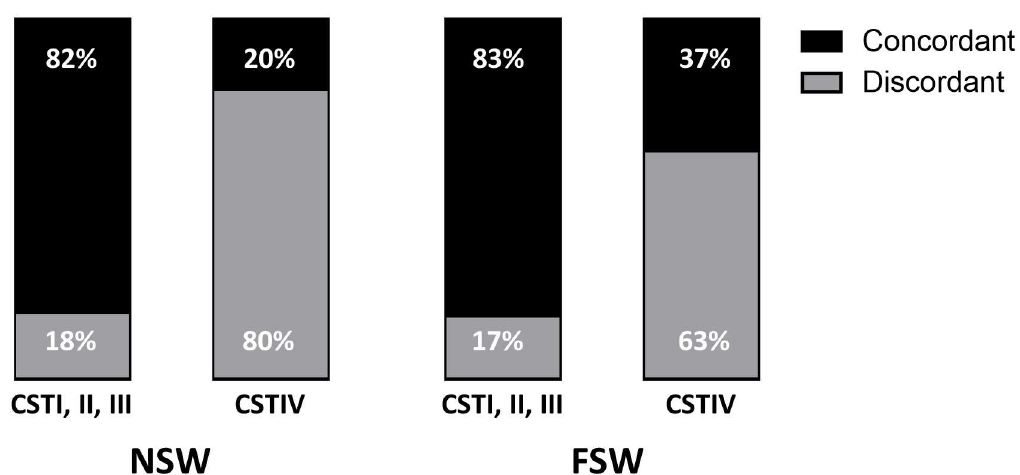
Fig 7. Concordance between bacterial morphotypes observed during Nugent Scoring and bacterial genera described by 16S sequencing. The top 5 bacterial generafor each woman were enumerated and comparedto the raw bacterialmorphotype scores ( Lactobacillus morphotypes, G . vaginalis/Bacteroides morphotypes, Mobiluncus morphotypes) obtainedduringNugent Scoring. The 16S and bacterial morphotypes were consideredto be in complete agreementif the top 5 generaobtainedby 16S sequencing includedall organismsviewedby microscopy. Overall concordance rate for NSW was 63% (10/16) completeagreement, and 44% (18/41) completeagreementfor FSW. After stratifying by Community State Type (CST) ( Lactobacillus dominant vs. high diversity), concordance rates were found to be related to CST. Concordance rates were greater for women in CSTI, II, III as comparedto CSTIV, regardless of whetherthey were NSW or FSW (9/11, 82% vs. 1/5, 20% in NSW and 5/6, 83% vs. 13/35, 37% in FSW). CST: community state type. FSW: Female Sex Worker. NSW: Non Sex Worker.